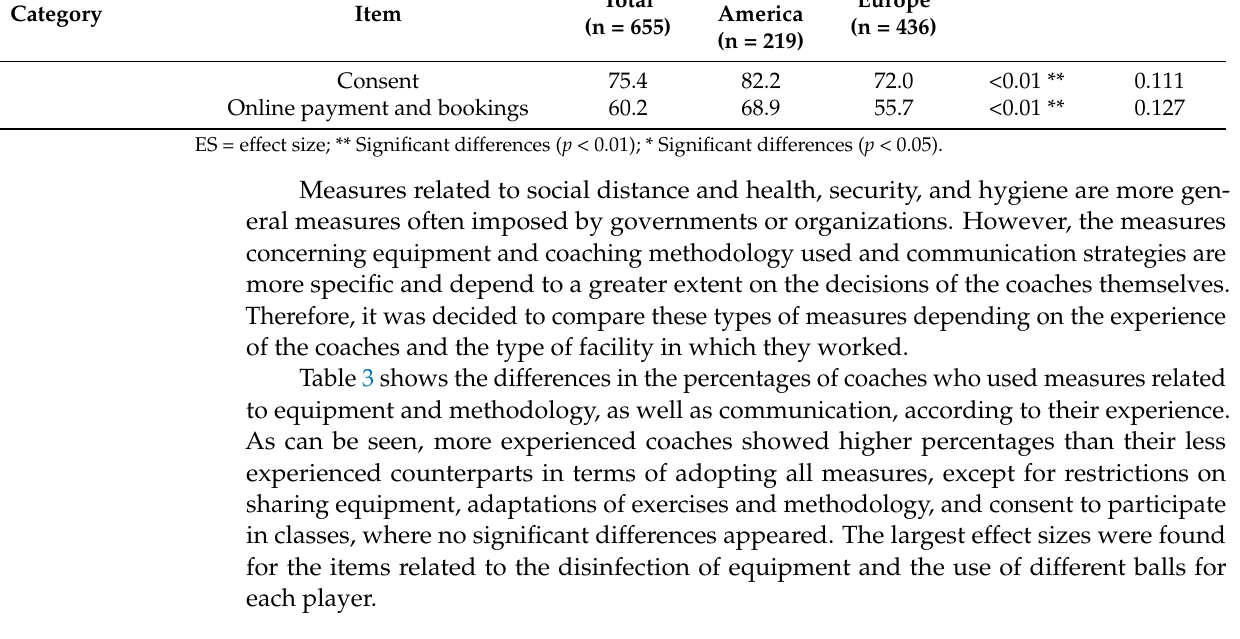
Table 3. Percentage of coaches who implemented the equipment and coaching methodology measures and communication according to their experience.